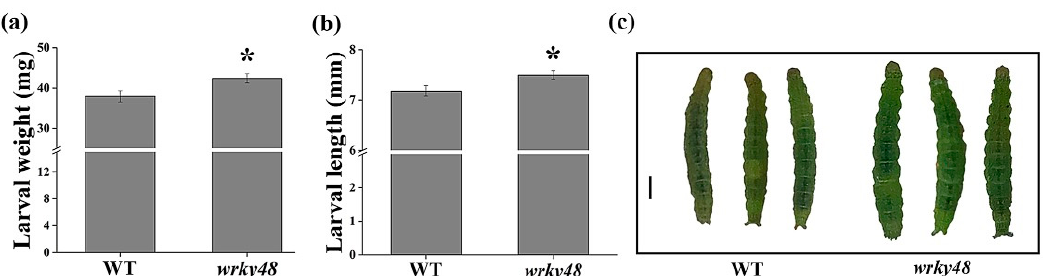
Figure 6. Insect feeding trials on the atwrky48 mutant. Average weight ( a ) and length ( b ) of Plutella xylostella L. larvae reared on WT and atwrky48 mutant plants for six days. The mean and SE were derived from 60 biological replicates. * p < 0.05, Student’s t -test. ( c ) Photographs of representative Plutella xylostella L. larvae recovered from WT and atwrky48 mutant plants after six days of feeding. Scale bar = 1 mm.